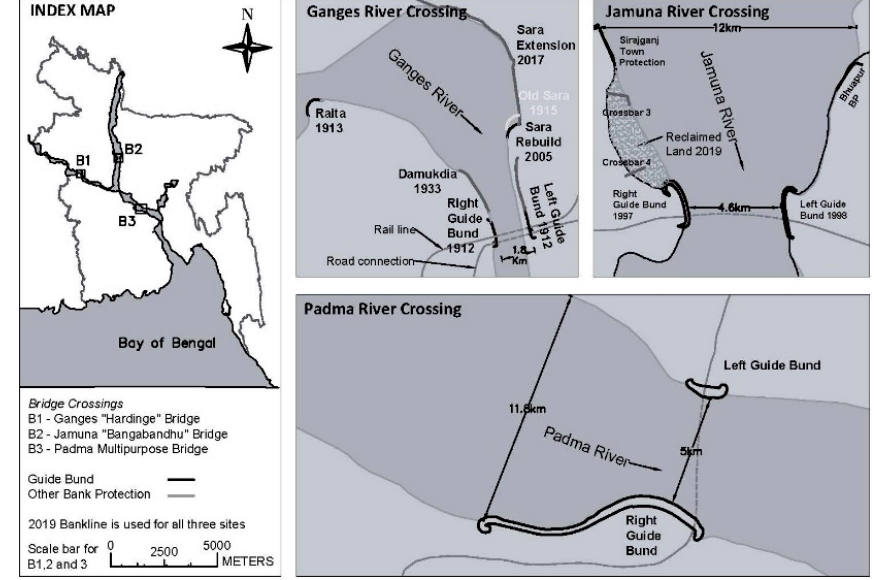
Figure 4. Comparison of guide bunds for the three major bridge crossings in Bangladesh. Table 1. Comparison of river training works in Bangladesh (RTW = river training